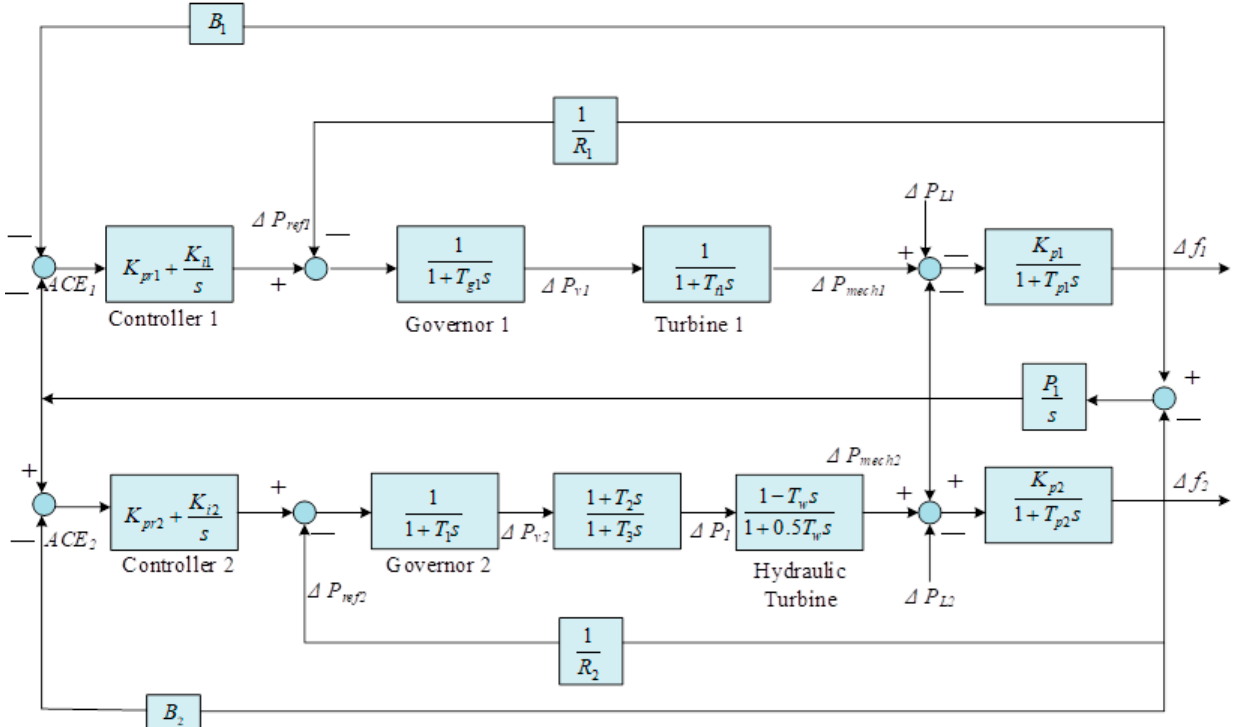
Figure 1. Test system model using transfer